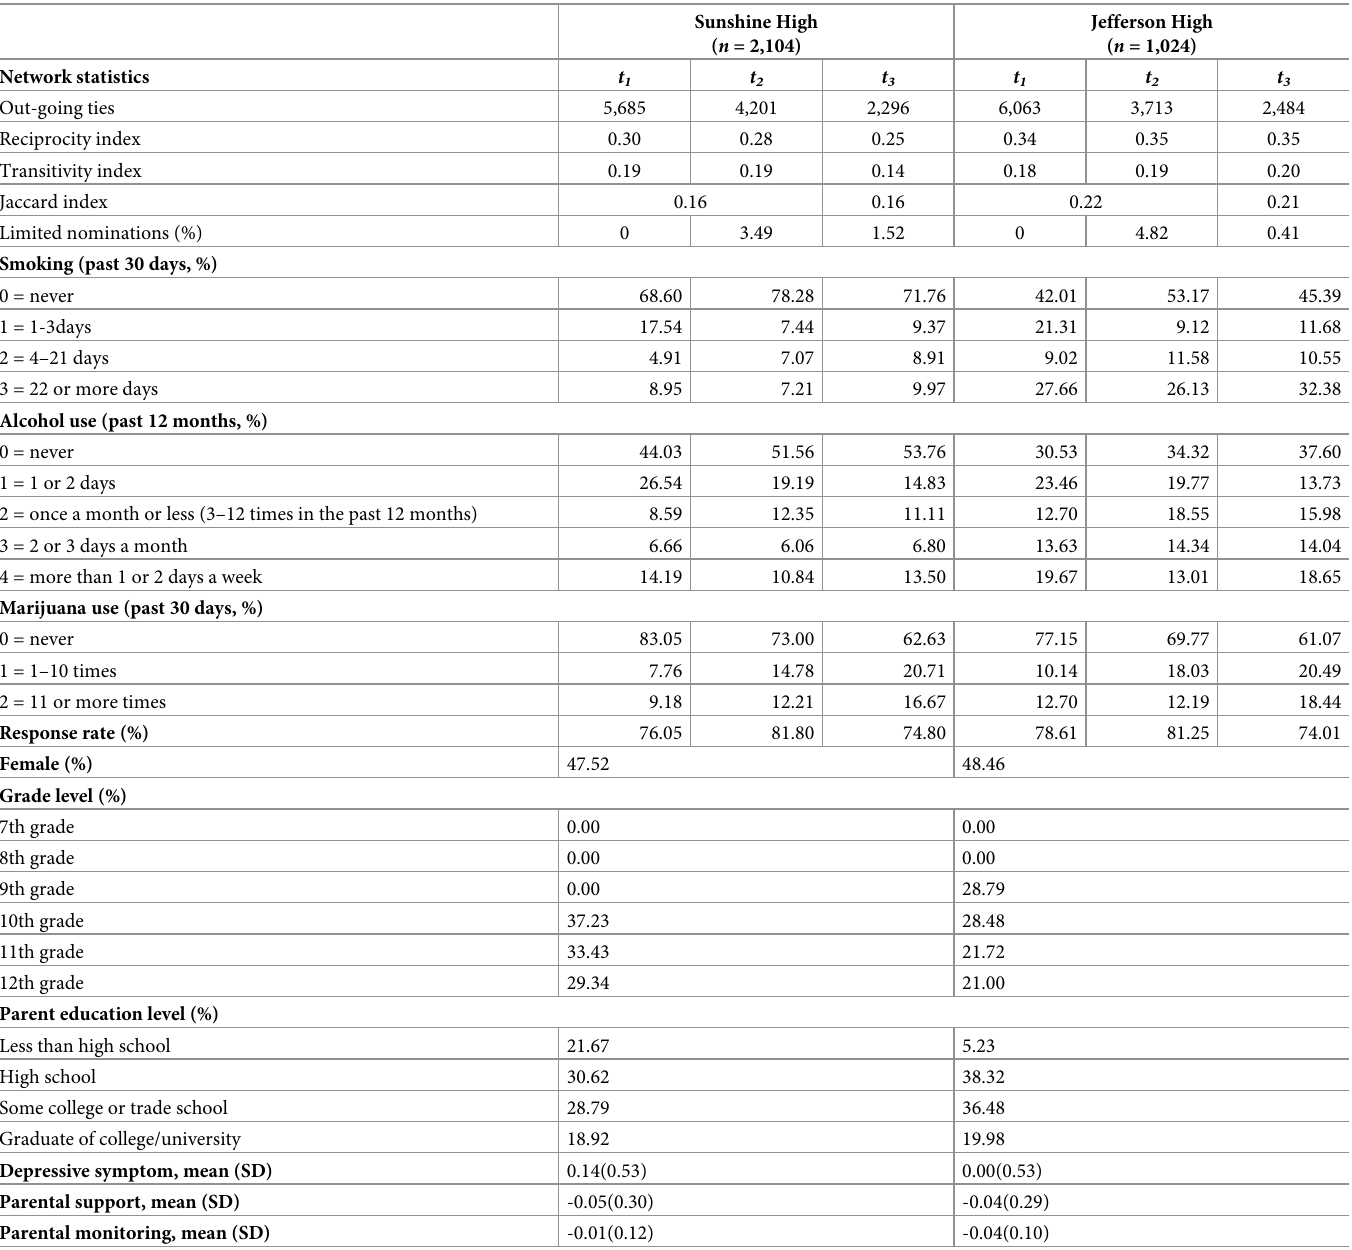
Table 1. Descriptive